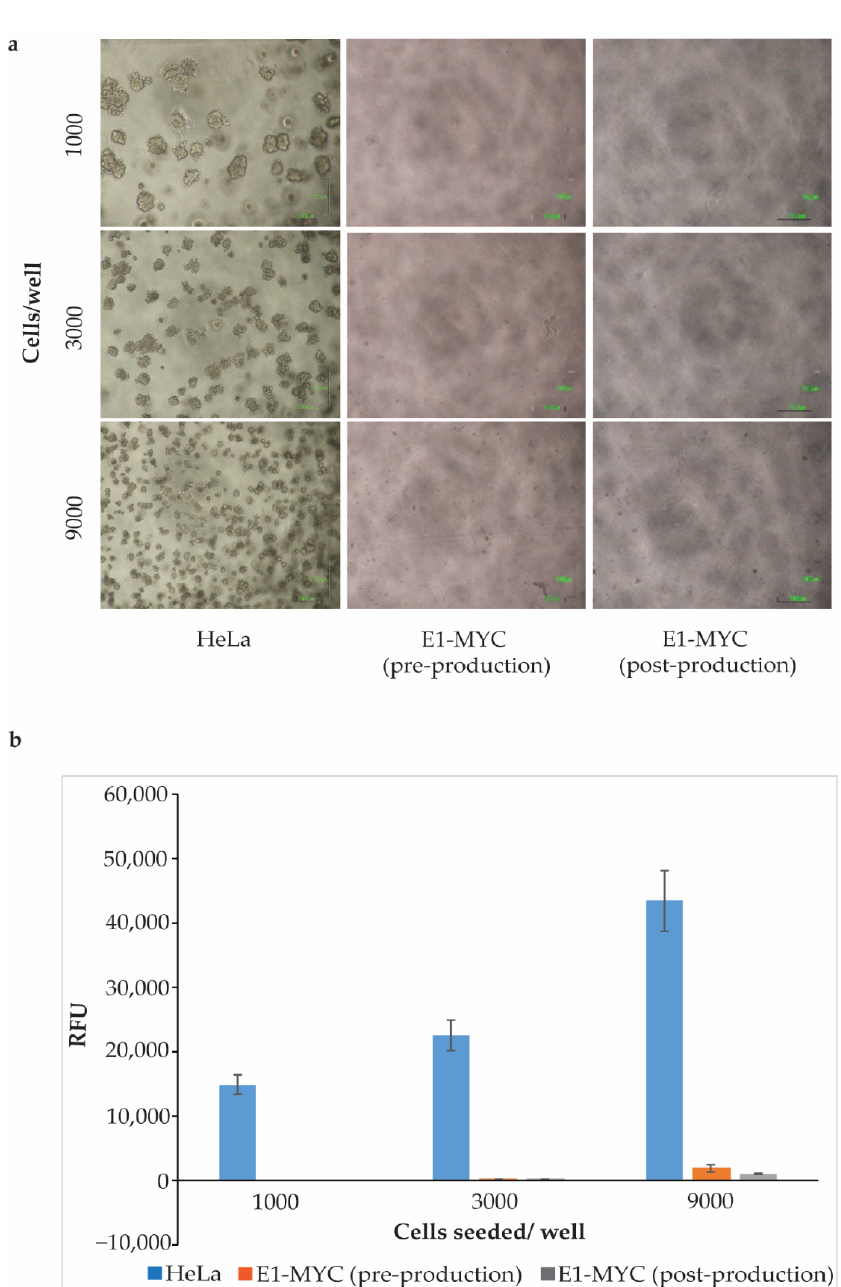
Figure 1. Anchorage-independent growth. HeLa cells and E1-MYC cells from pre- or post-production medium were seeded at three different densities and cultured for 7 days. ( a ) Representative images (4× magnification) HeLa and E1-MYC cultures after 7 days. ( b ) Relative cell growth as determined by DNA-binding dye fluorescence after 7 days in culture. Results represent the mean ( n = 3, triplicate for each sample) ± SD.